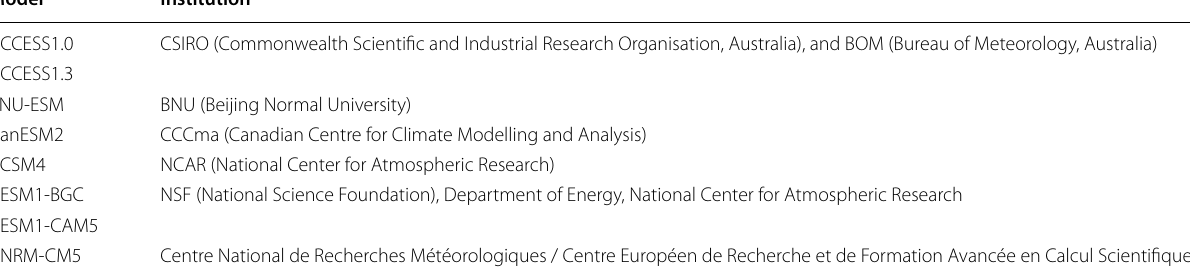
Table 3 Information for the CMIP5 dataset included in the CMIP5 experiments